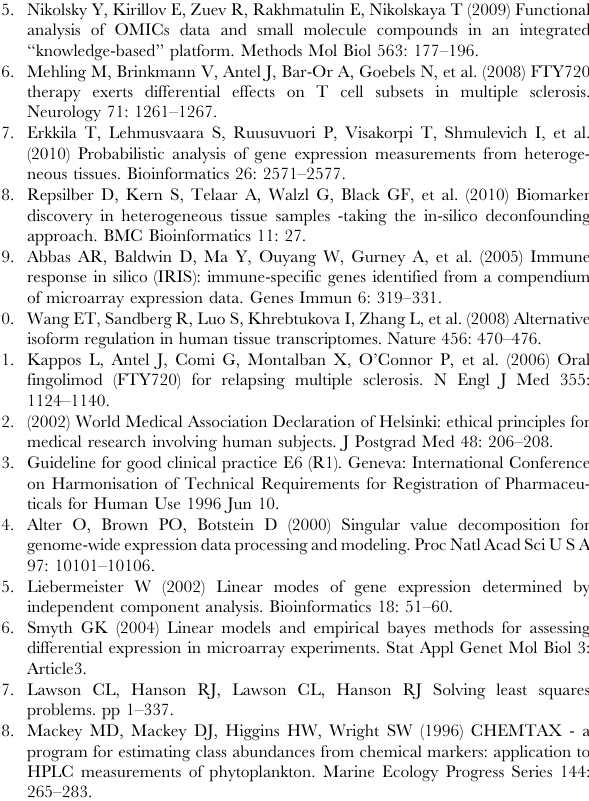
Table S1 Experimental design for rat liver vs . kidney microarray experiment. Table S2 Experimental design for rat brain vs. liver microarray experiment. Table S3 Gene Annotation for blood vs. breast, liver vs. kidney and liver vs. brain experiments. Table S4 Leukocyte types used as the basis for whole blood